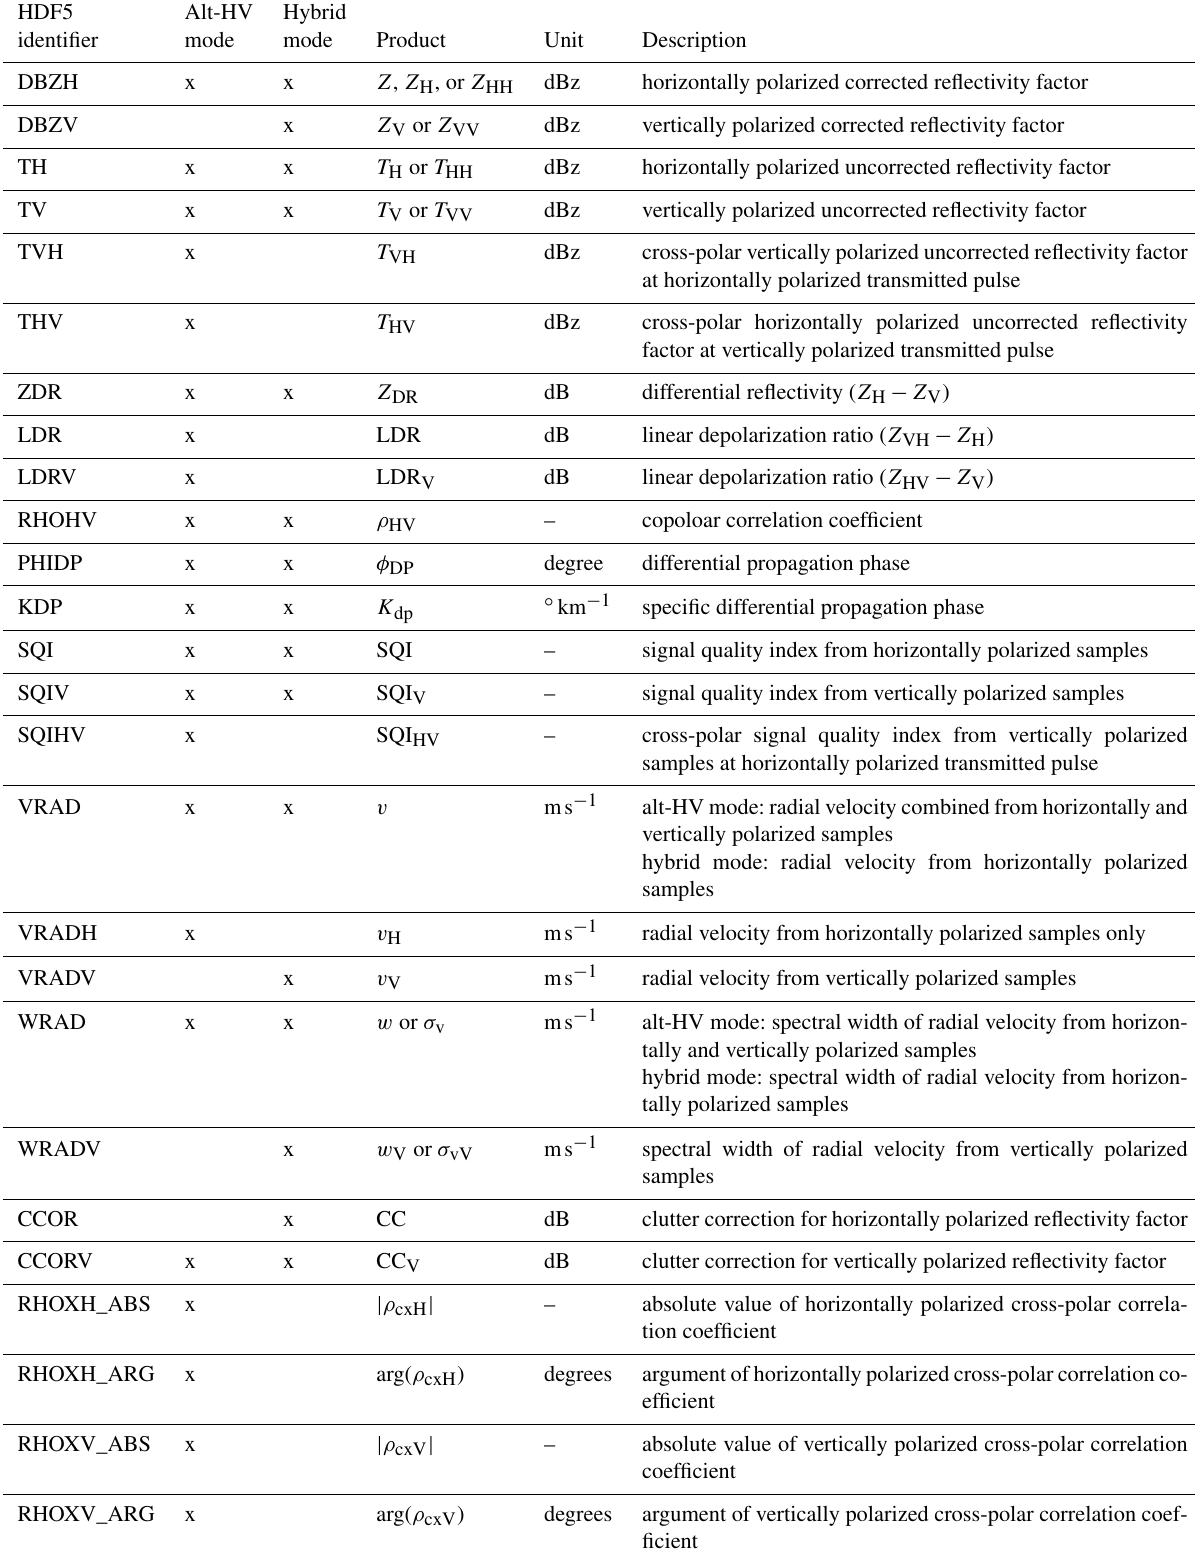
Table B1. Poldirad radar products and their HDF5 identifiers. Correlation coefficients and signal quality indices are dimensionless.